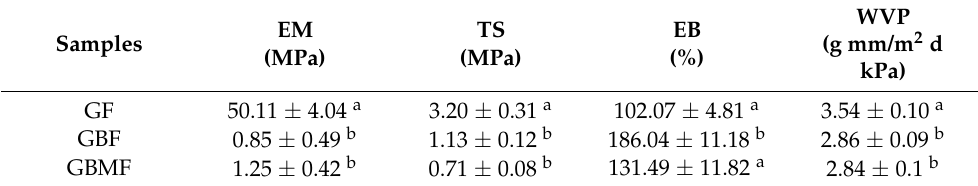
Table 3. Mechanical properties and WVP of different films.